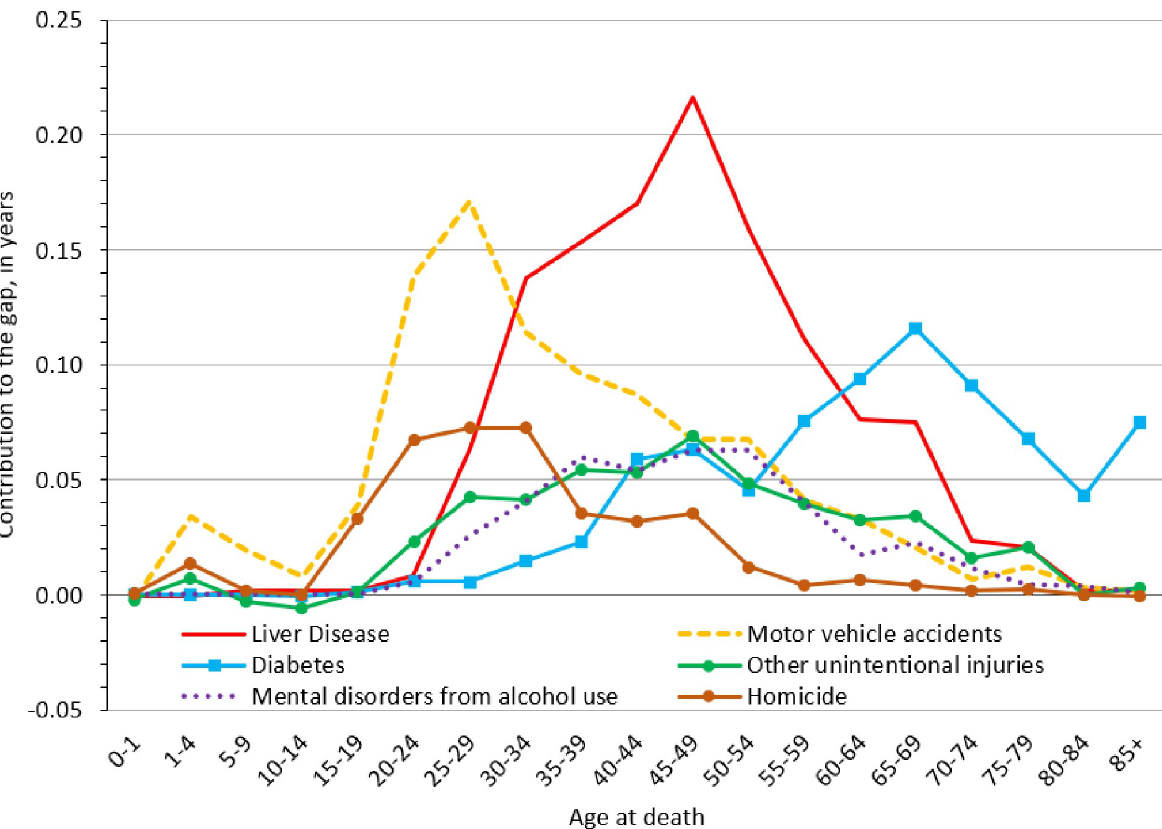
Fig 2. Native American-White life expectancy gap in the Four Corners States among males, 2015. The life expectancy gap was decomposed into various causes of death at specific ages. Estimates for 2015 represent a 5-year aggregation of data (i.e., 2013–2017).